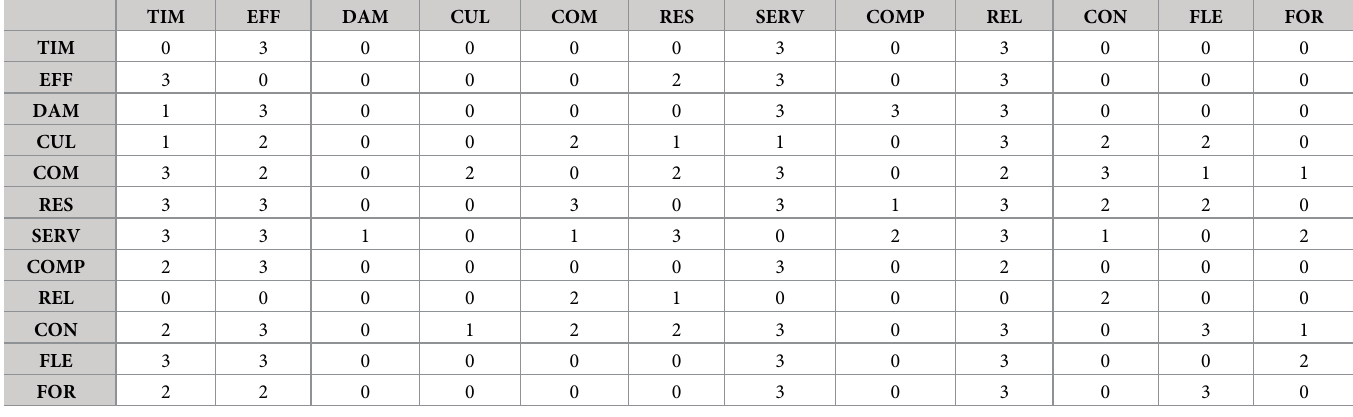
Table 3. Impact strength of twelve